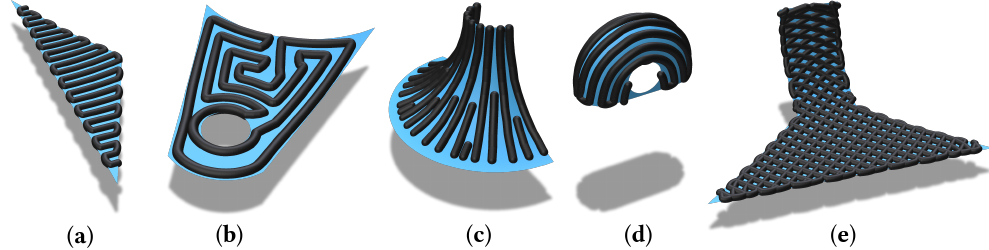
Figure 7. ( a ) FExA on surface A ( b ) Geo-FISO on surface B ( c ) Ortheo on surface C with surface D as source with d iso = 1 mm ( d ) FInA on surface D ( e ) FInA twice with orthogonal planes on surface E. For all paths d = 2 mm for illustration purposes, planes chosen to align with the vector field. Filament thickness displayed does not correspond to thickness when